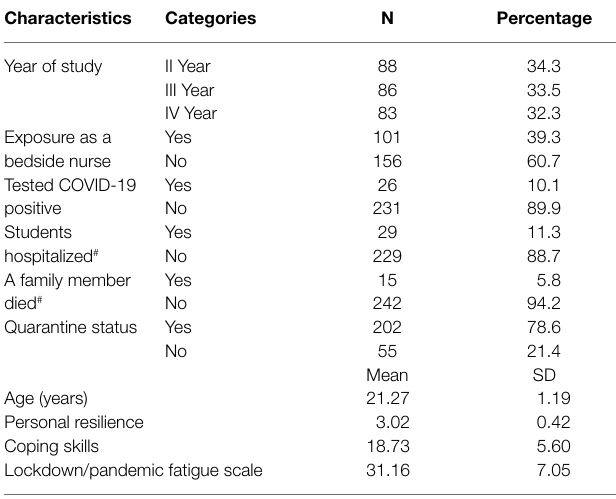
TABLE 1 | Students’ characteristics ( n = 256).